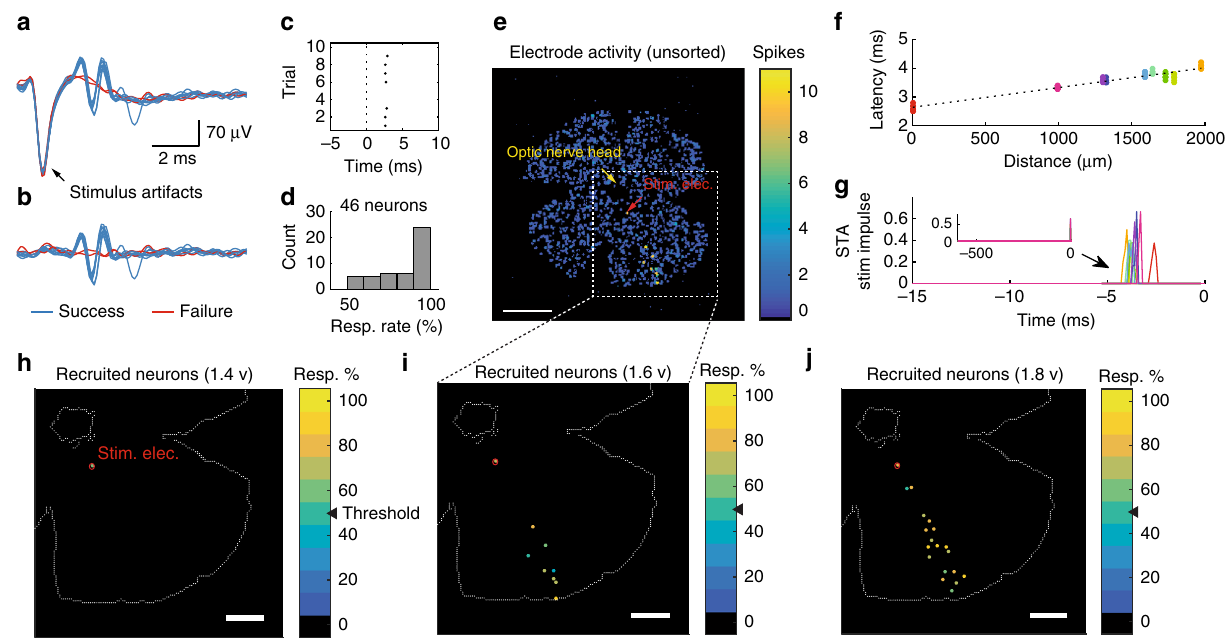
Fig. 5 Spatiotemporal effects of microstimulation revealed by large-scale electrophysiology. A grid of 2 × 2 electrodes was used throughout. Besides h and j , 1.6 v pulses were used. a Simultaneous stimulation and recording at one electrode. Superimposed traces from 10 trials. b Same data as a , after removing the stimulus artifacts. c Raster plot for the evoked spikes in b . d Response rate (10 trials) of 46 RGCs in two retinas. e Events detected within 3 ms of stimulus onset. The stimulation site is marked by the red arrow. Aggregated data from 10 repetitions. Scale bar, 1275 µ m. f Latency of the evoked spikes increased with distance from the stimulation site. Each dot represents a spike (69 in total). The colors denote different neurons. Dotted line is linear fi t ( R 2 = 0.9541, p < 0.0001, F-test). g Time course of spike-triggered average (STA) stimulus for each (color-matched) neuron in f . h – j Spike-sorted activity maps of identi fi ed neurons. The number of distant neurons activated by electrical stimulation increased with stimulus strength. The colors indicate response rate over 10 trials. Dotted lines are approximate outline of the retina. Scale bar, 765 µ